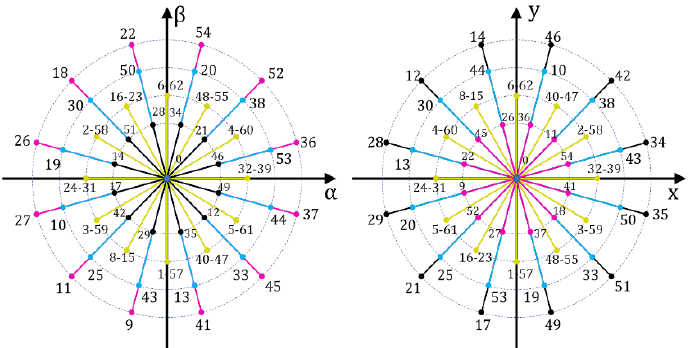
Figure 1. Asymmetrical six-phase IM ( 𝛿 = 30 ° ) drive topology.